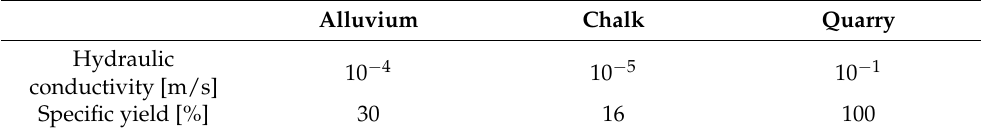
Table 2. Calibrated hydraulic parameters values used in the groundwater flow model of the Obourg quarries. Alluvium Chalk Quarry Hydraulic 10 − 4 10 − 5 10 − 1 conductivity [m/s] Specific yield [%] 30 16